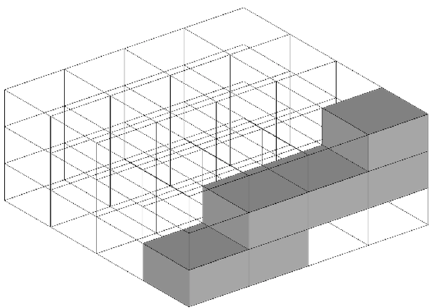
Figure 6. A batch of 6 blocks violating rule 3 as the cantilevered ‘balcony’ size exceeds the